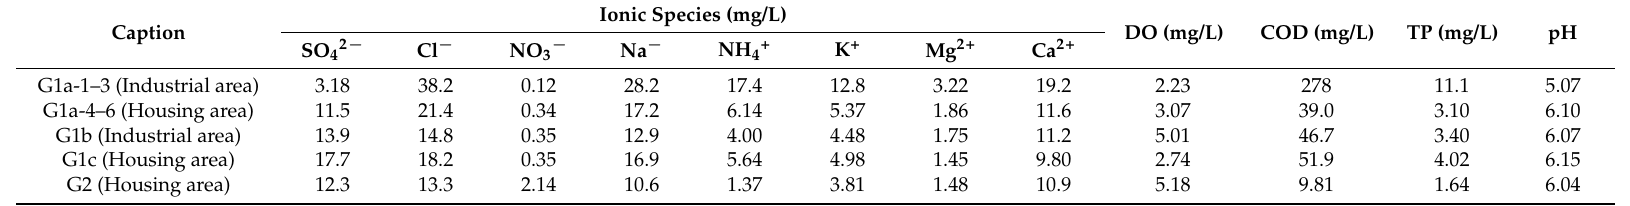
Table 1. Average value of ionic species and water quality indexes (WQIs) in different areas of